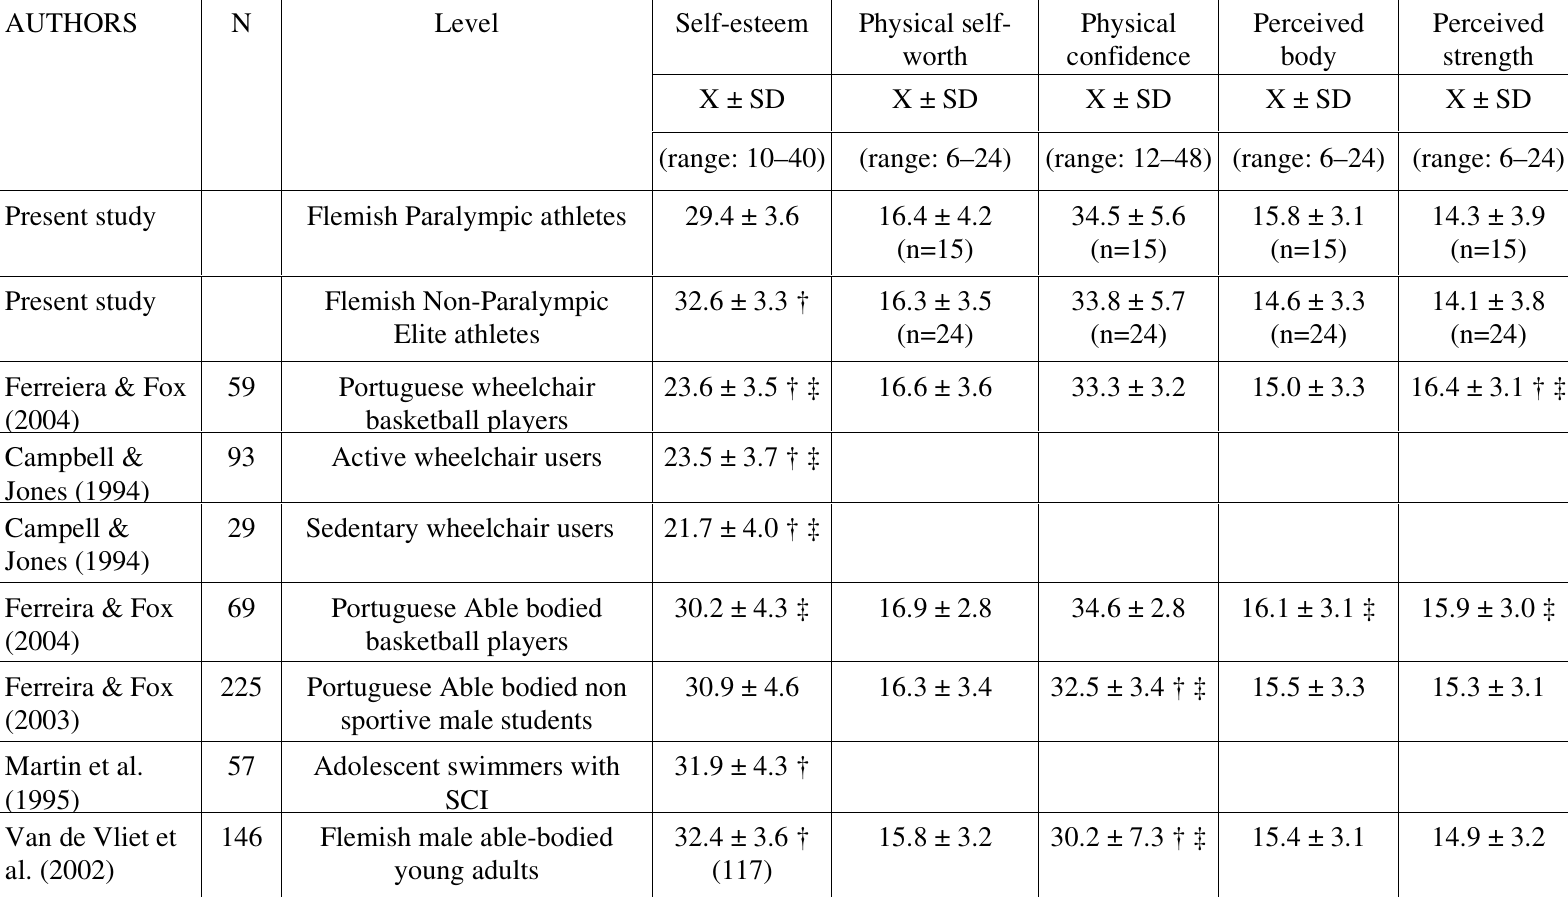
Self-esteem and (physical) self-perceptions in Flemish Paralympic and Non-Paralympic Elite athletes in comparison to other athletes with a disability and able-bodied individuals [comparisons made at time 1, 11 months prior to Paralympic